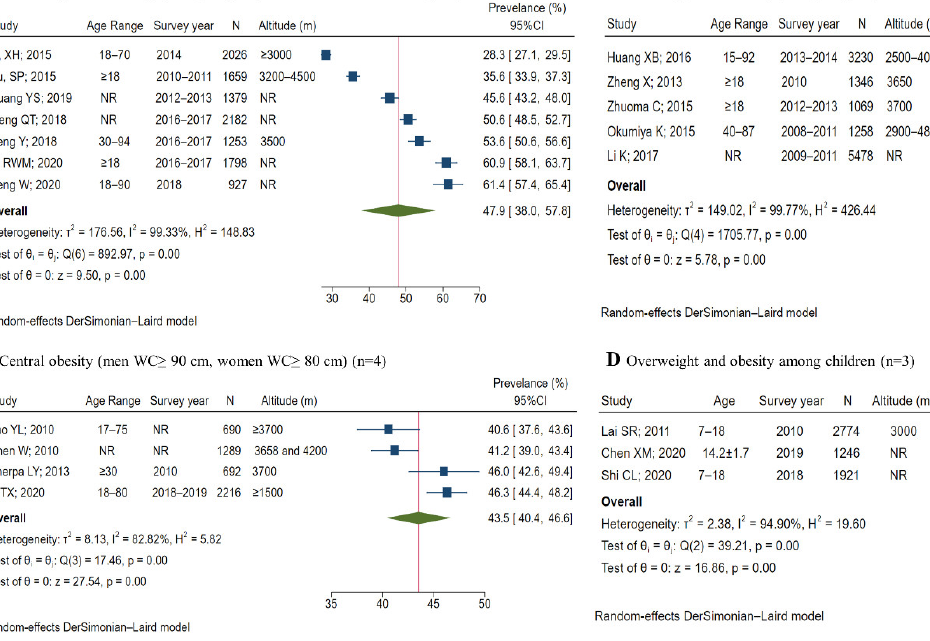
Figure 2. Meta-analysis of pooled prevalence of overweight, obesity, and central obesity among Tibetans [26,27,29,31–36,42,43,45–48,52,55,59,61]. Abbreviations: BMI: body mass index; NR: not reported; M: mean; SD: standard deviation; WHO: World Health Organization; WC: waist circumfer- ence. Diagnostic criteria: among adults, overweight and obesity was defined as BMI ≥ 24 kg/m 2 based on Chinese criteria; overweight and obesity was defined as BMI ≥ 25 kg/m 2 based on the WHO criteria; central obesity was defined as waist circumference (WC) ≥ 90 cm for men and WC ≥ 80 cm for women. For children, the Chinese BMI criteria for overweight and obesity were used. Prevalence and 95% CI were calculated using random-effects